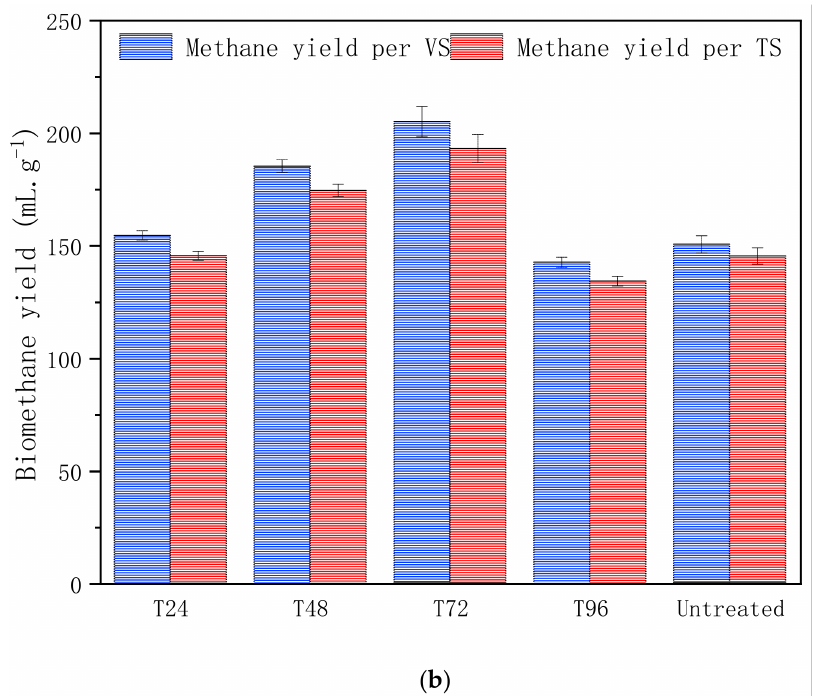
Figure 2. ( a ) Daily biomethane productions for pretreated and untreated corn stover; ( b ) Biomethane yields for pretreated and untreated corn